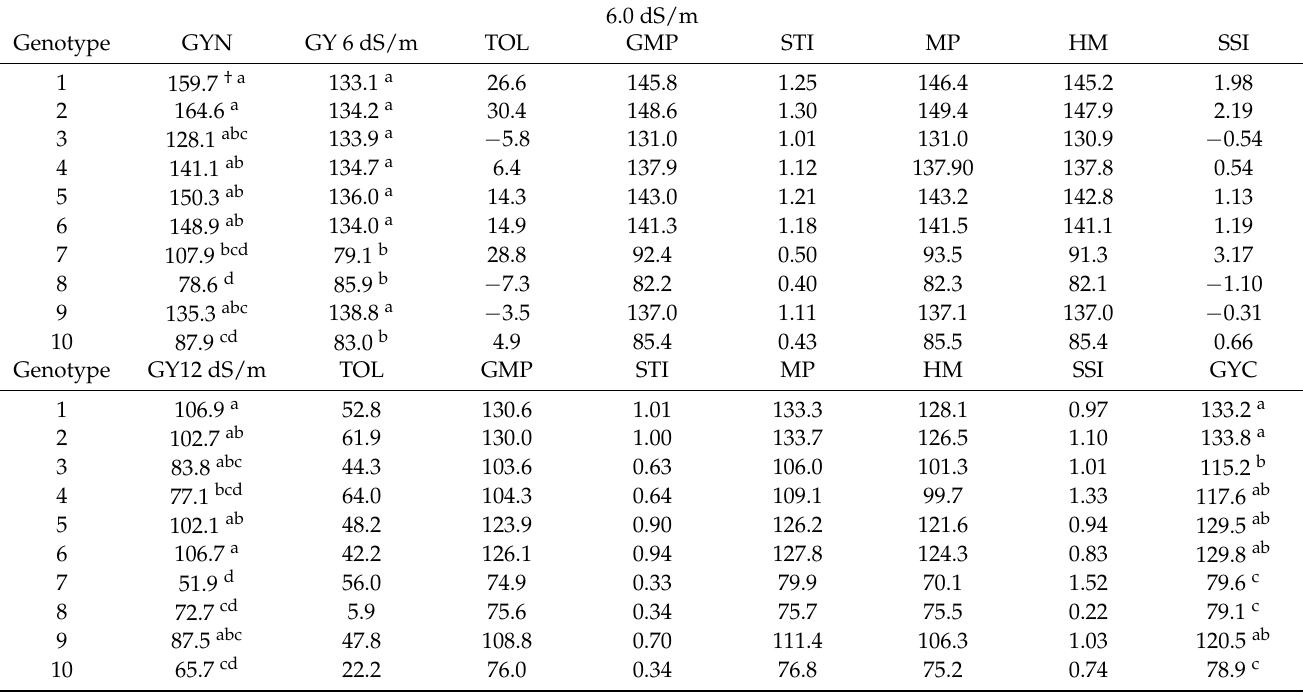
Table 8. Grain yield gm per row and salinity tolerance/susceptible indices, along with grain